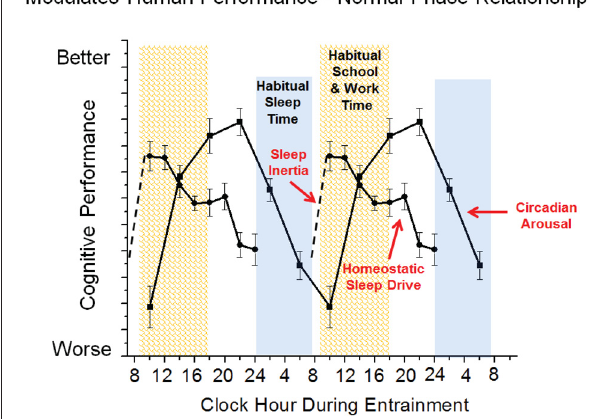
FIGURE 3 | Simplified model of wakefulness-sleep and circadian modulation of cognition. Data are double plotted and show individual contribution of sleep inertia (grogginess upon awakening from sleep), homeostatic sleep drive (time awake and prior sleep history) and circadian phase (internal biological time) modulation of cognitive function under typical